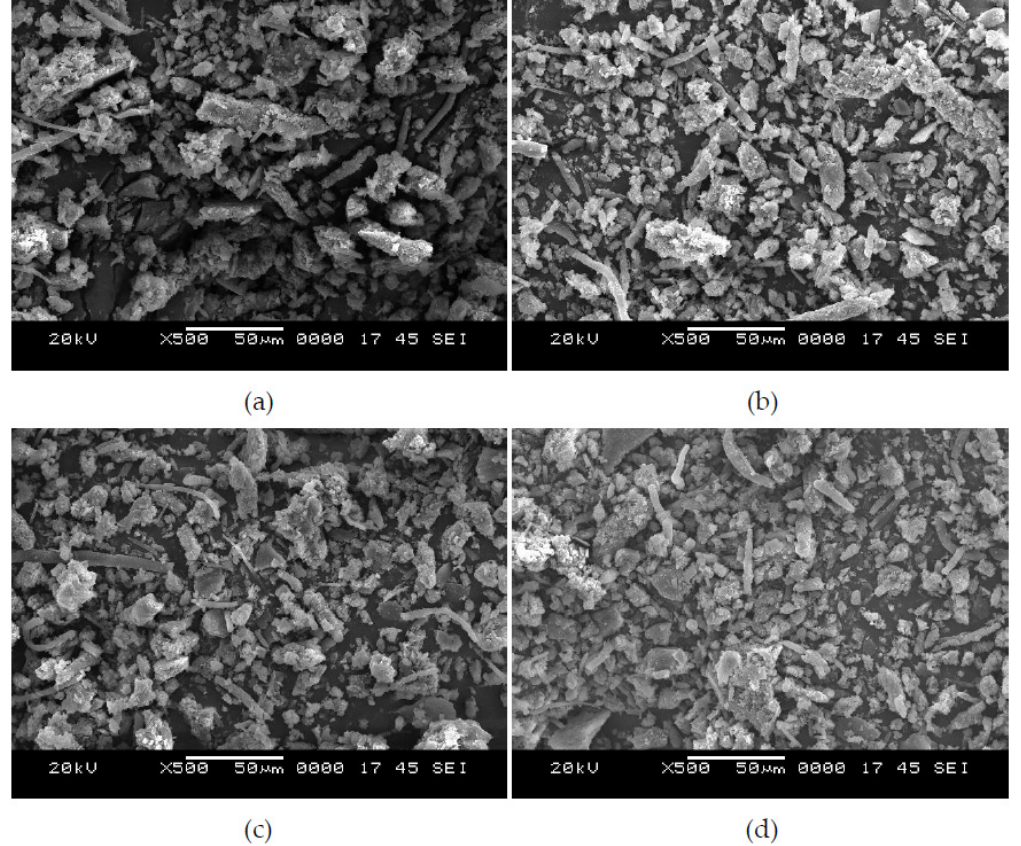
Figure 9. Morphology of wear debris of EC-10 at ( a ) 30 N and ( b ) 50 N; and EC-30 at ( c ) 30 N and ( d ) 50 N.